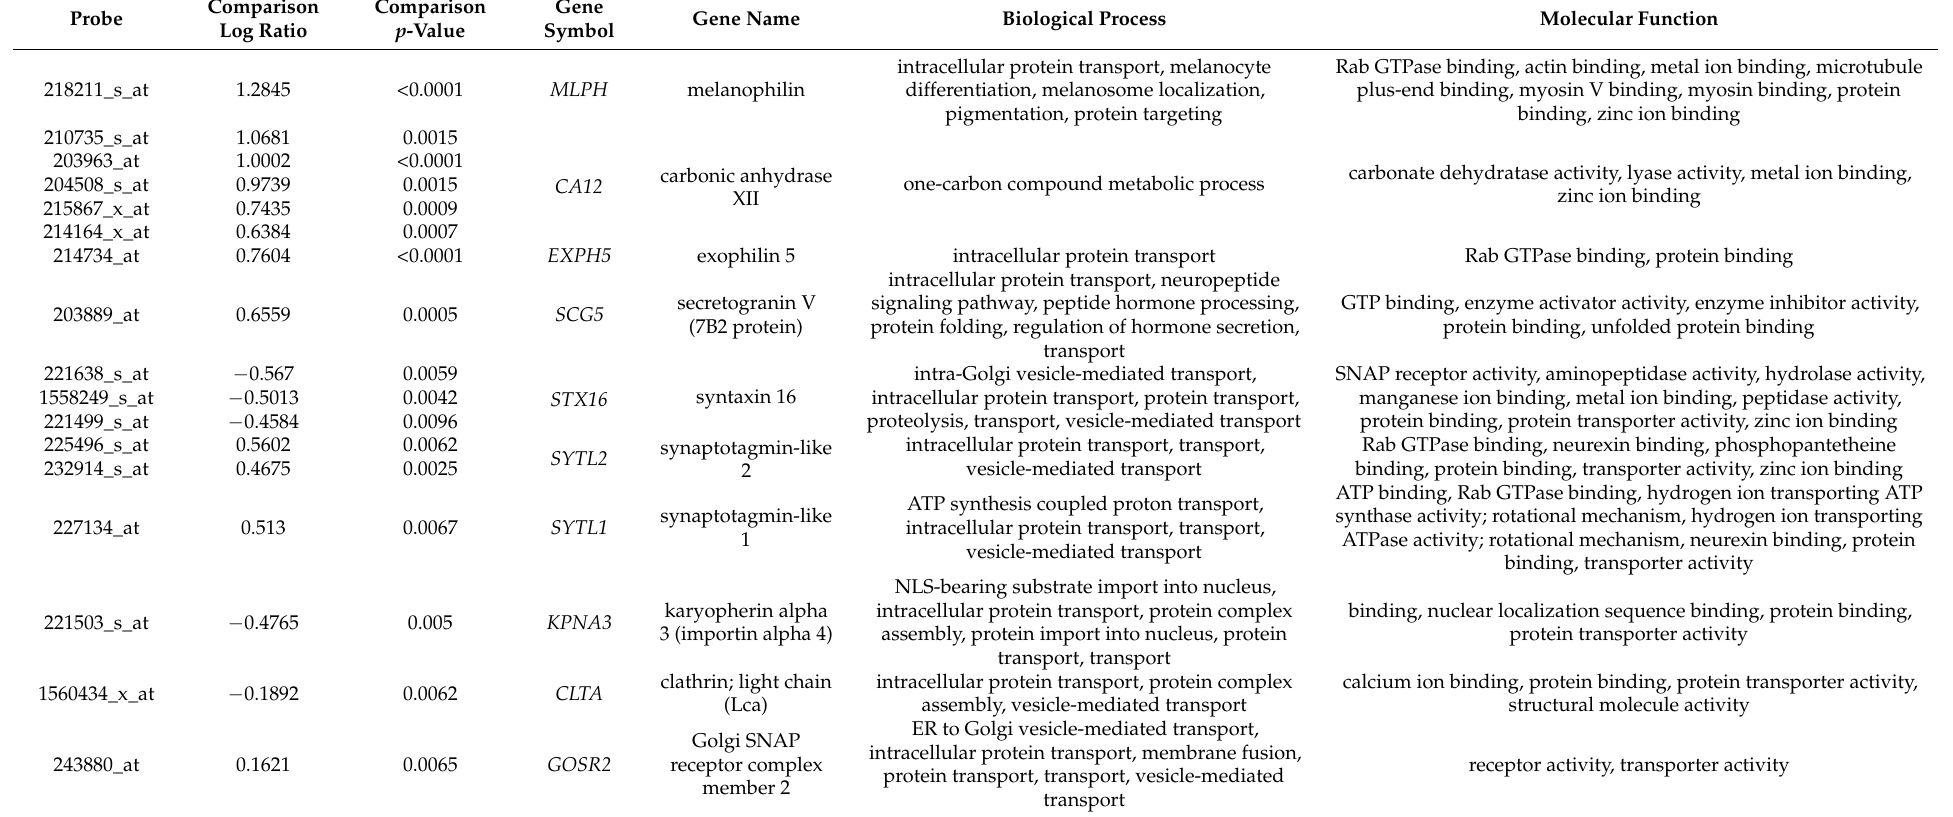
Table 1. Summary of differentially expressed genes associated with intracellular protein transport (GO: 0006886) in relation to response to chemoradiation in rectal